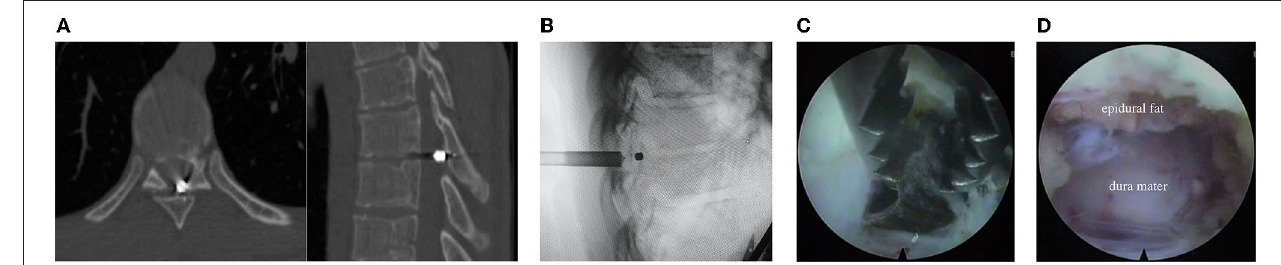
FIGURE 3 | (A) CT scans of the thoracic spine (explained in the text); (B) Radiography of the working port and bullet; (C,D) Endoscopic stage of the surgery (described in the